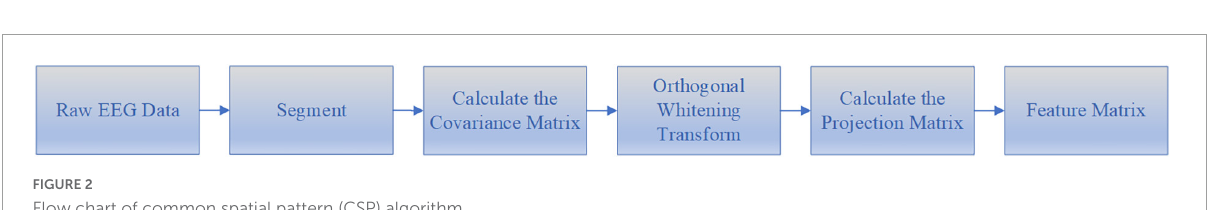
FIGURE2 Flow chart of common spatial pattern (CSP)